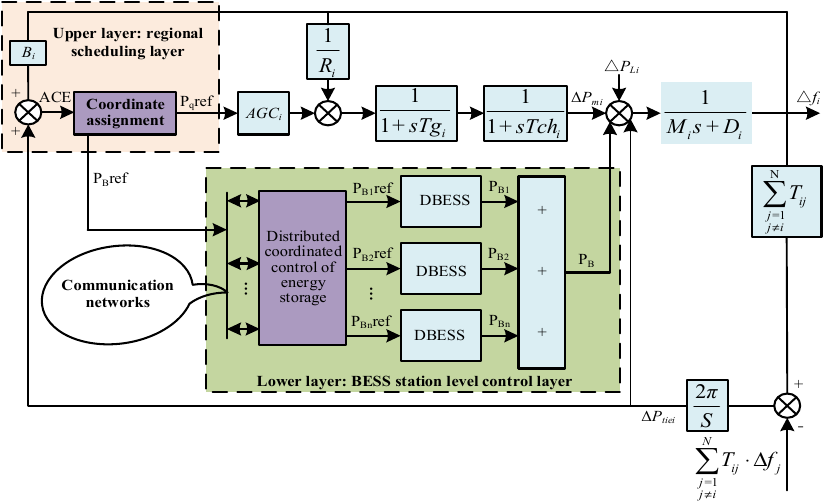
Figure 1. Frequency dynamic response model of regional power grid with BESS.